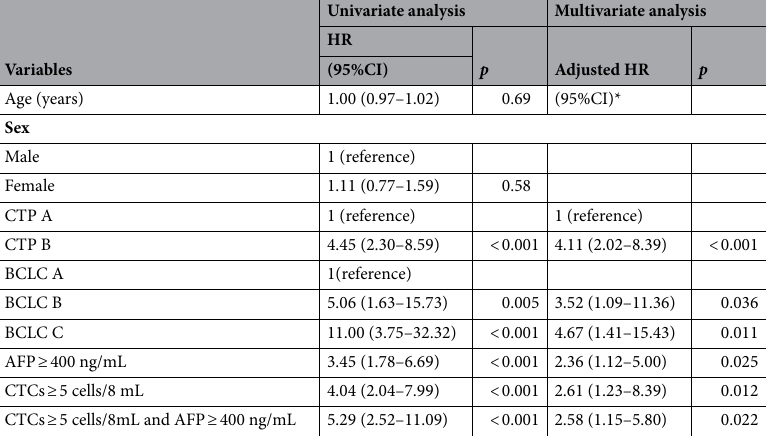
Table 3. Univariate and multivariate Cox regression analysis of factors associated with overall survival of HCC patients. *Adjusted by age and sex.